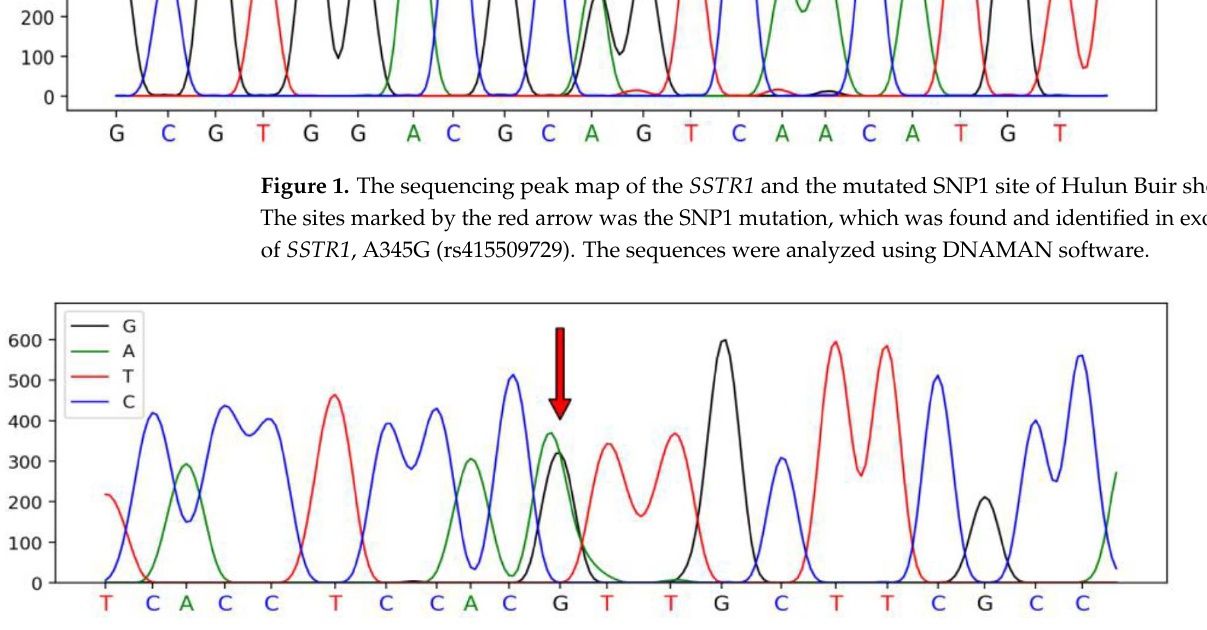
Figure 2. The sequencing peak map of the SSTR1 and the mutated SNP2 site of Hulun Buir sheep. The sites marked by the red arrow was the SNP2 mutation, which was found and identified in exon 2 of SSTR1 , A285G (rs426187704). The sequences were analyzed using DNAMAN software.